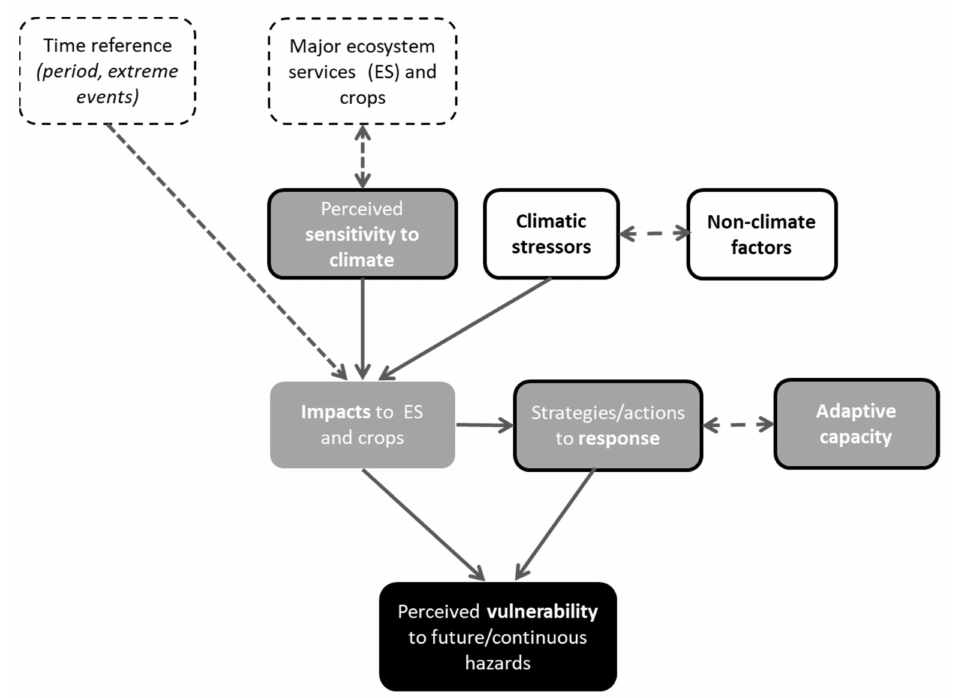
Figure 2. Conceptual framework of the study applied in the FGD